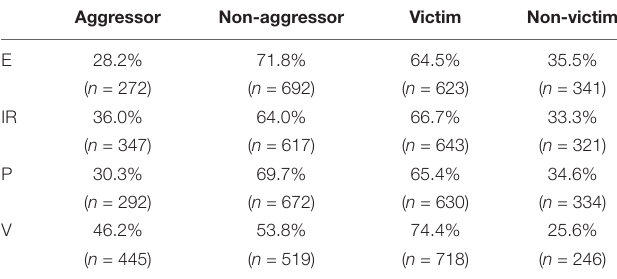
TABLE 1 | Percentage of roles of involvement and types of aggression manifested. Aggressor